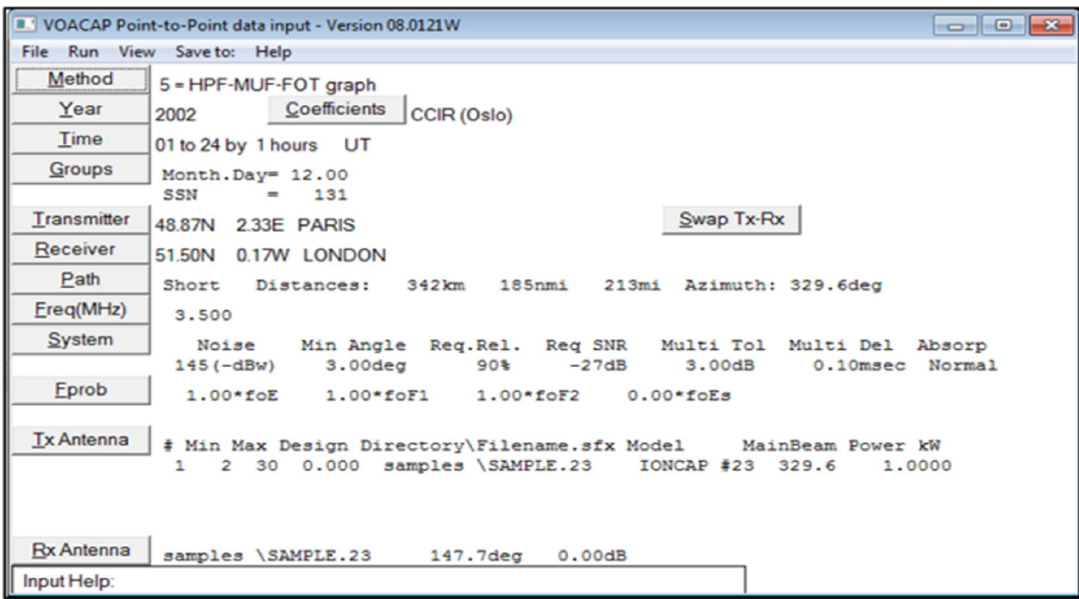
Fig. 1. Shows VOACAP program